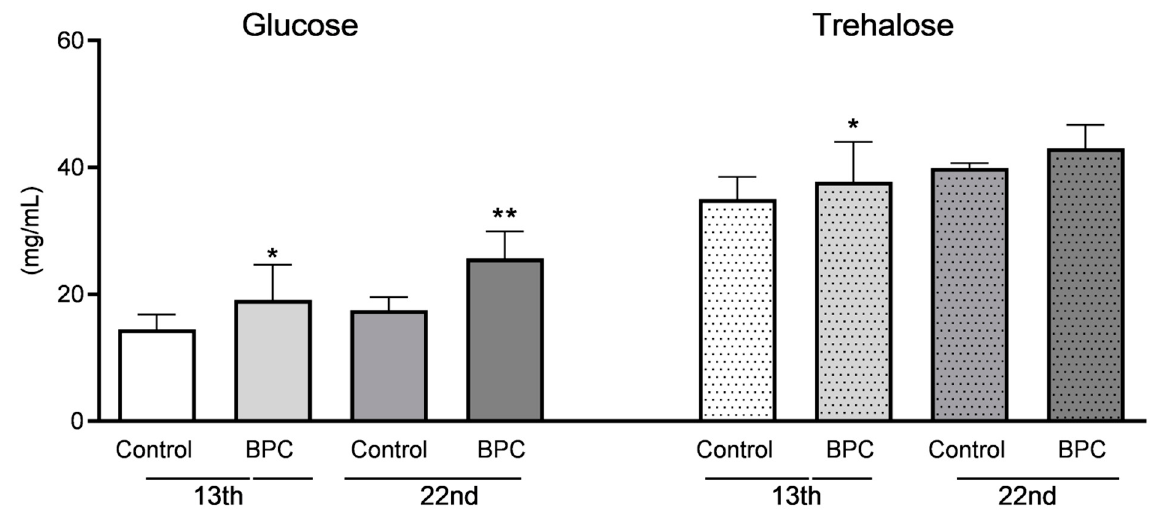
Figure 4. Carbohydrate’s concentrations in adult honeybee hemolymph sampled on the 13th and 22nd day of the experiment under laboratory-controlled conditions for experimental the BPC and control groups. Asterisks indicate statistically significant differences: BPC vs. control, * p < 0.001, ** p < 0.0001; mean ± SD.